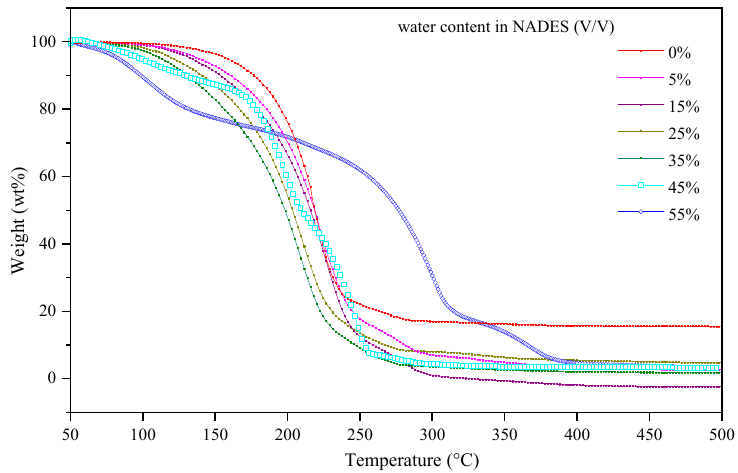
Figure 5. TG (in nitrogen) curves of NADESs with different water content levels.